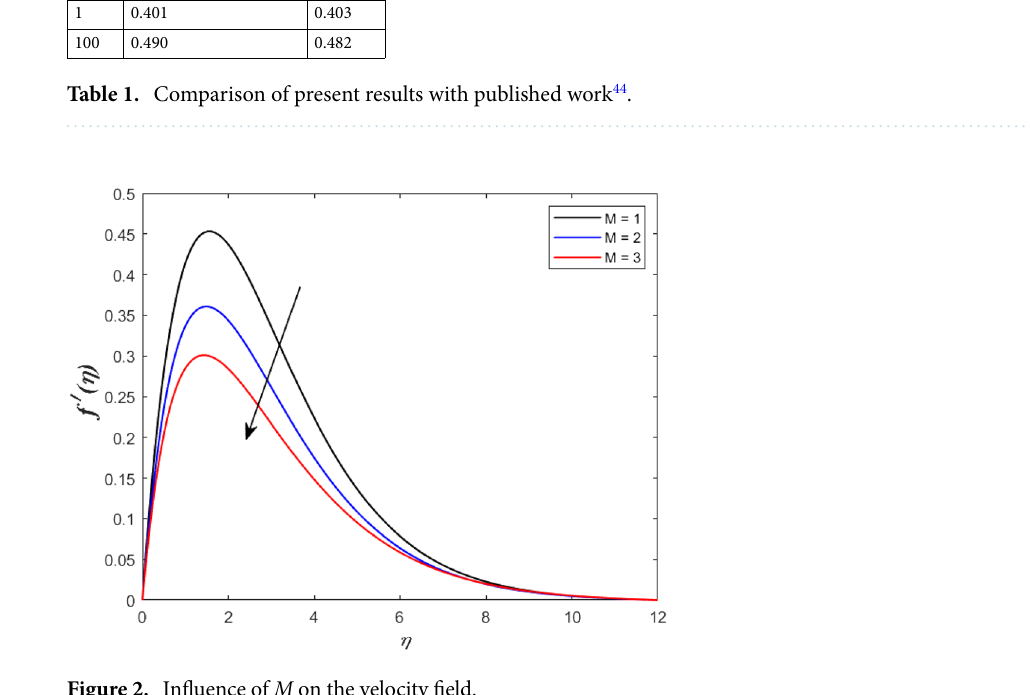
Figure 2. Influence of M on the velocity